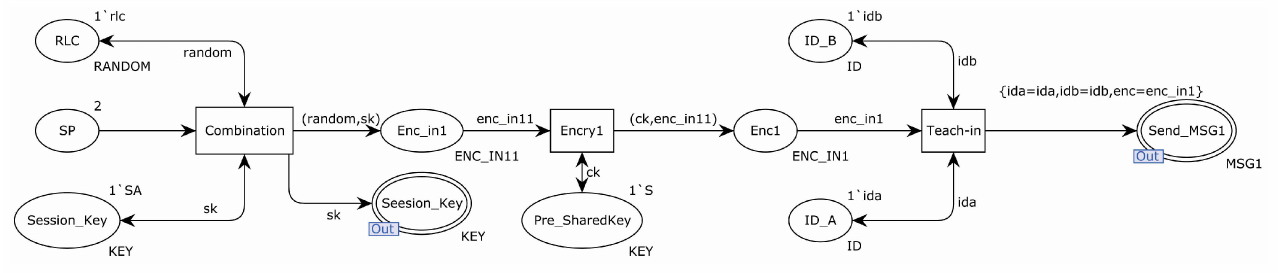
Figure 3. Substitution transition teach-in internal